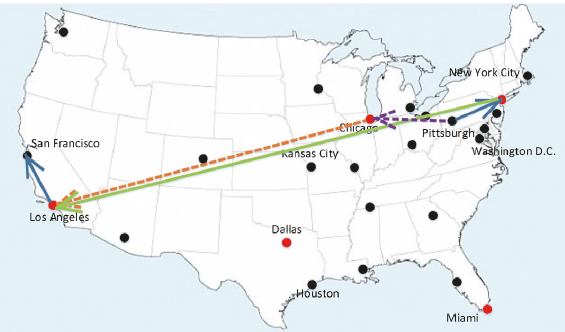
Figure 2: Hub-and-spoke structure and alternative routes: there exists a regular route from Pittsburgh to San Francisco with New York City and Los Angeles as hubs. If hub of New York City is disrupted, an alternative route “Pittsburgh → Chicago → Los Angeles → San Francisco” can be used. Note that, the Los Angeles hub is still in the alternative